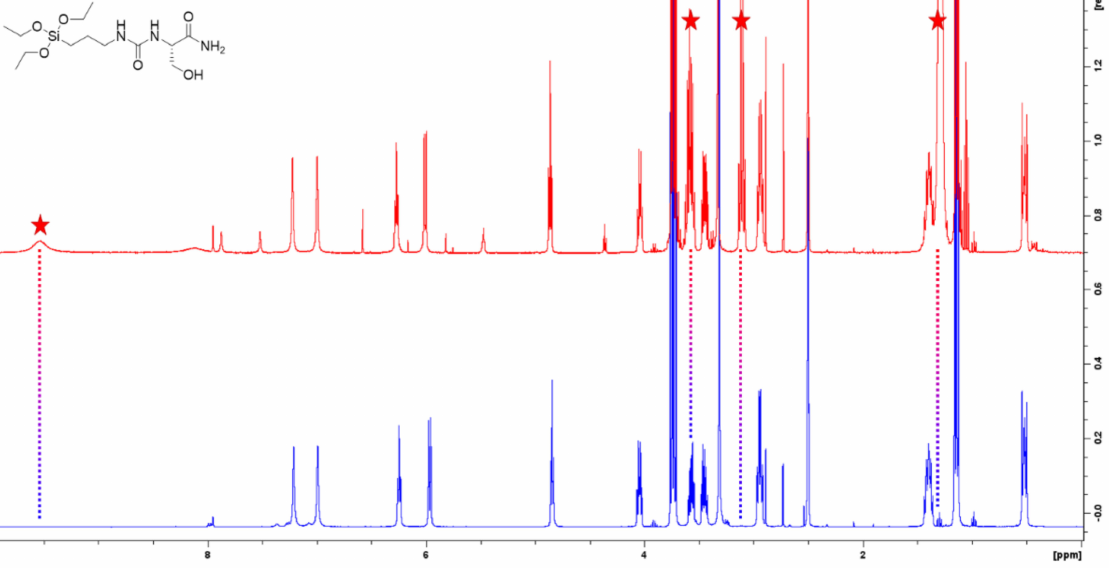
Figure 3. Comparison of 1 H NMR spectra of Si-Ser-NH 2 synthesized with DIEA (red) and sodium bicarbonate